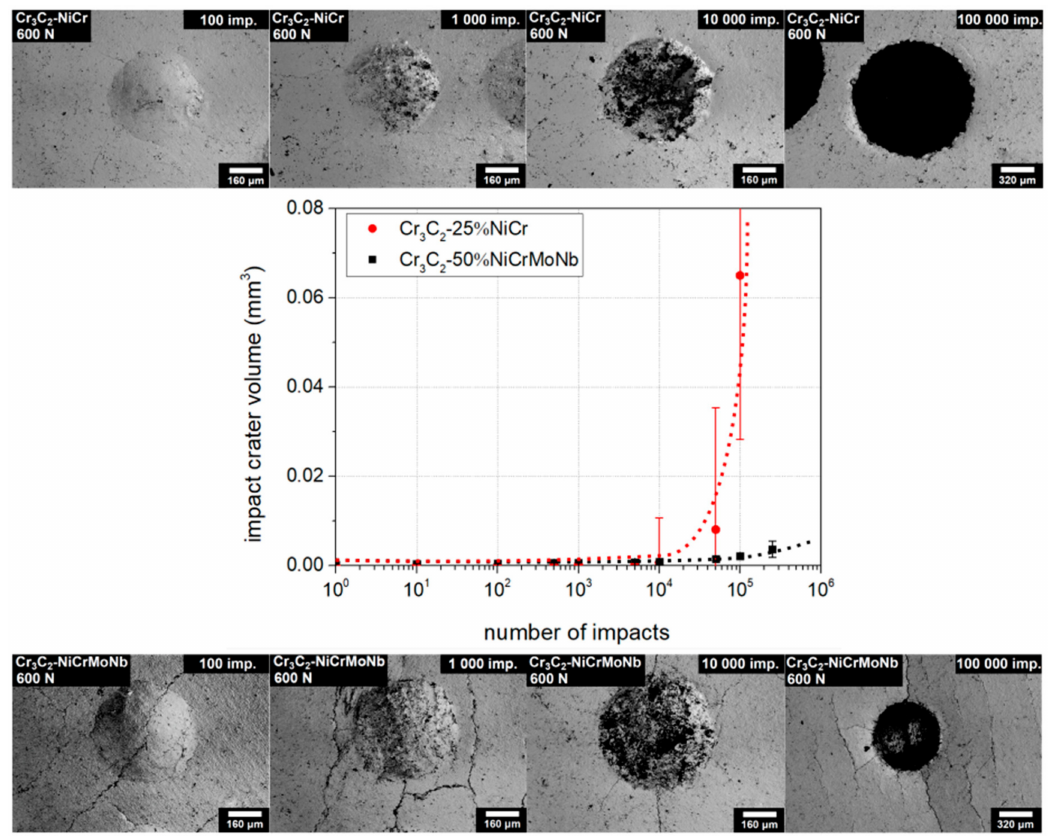
Figure 5. Comparison of the loading curves and impact craters of the studied coatings. The case for impact load of 600 N. Dotted lines were added as a visual